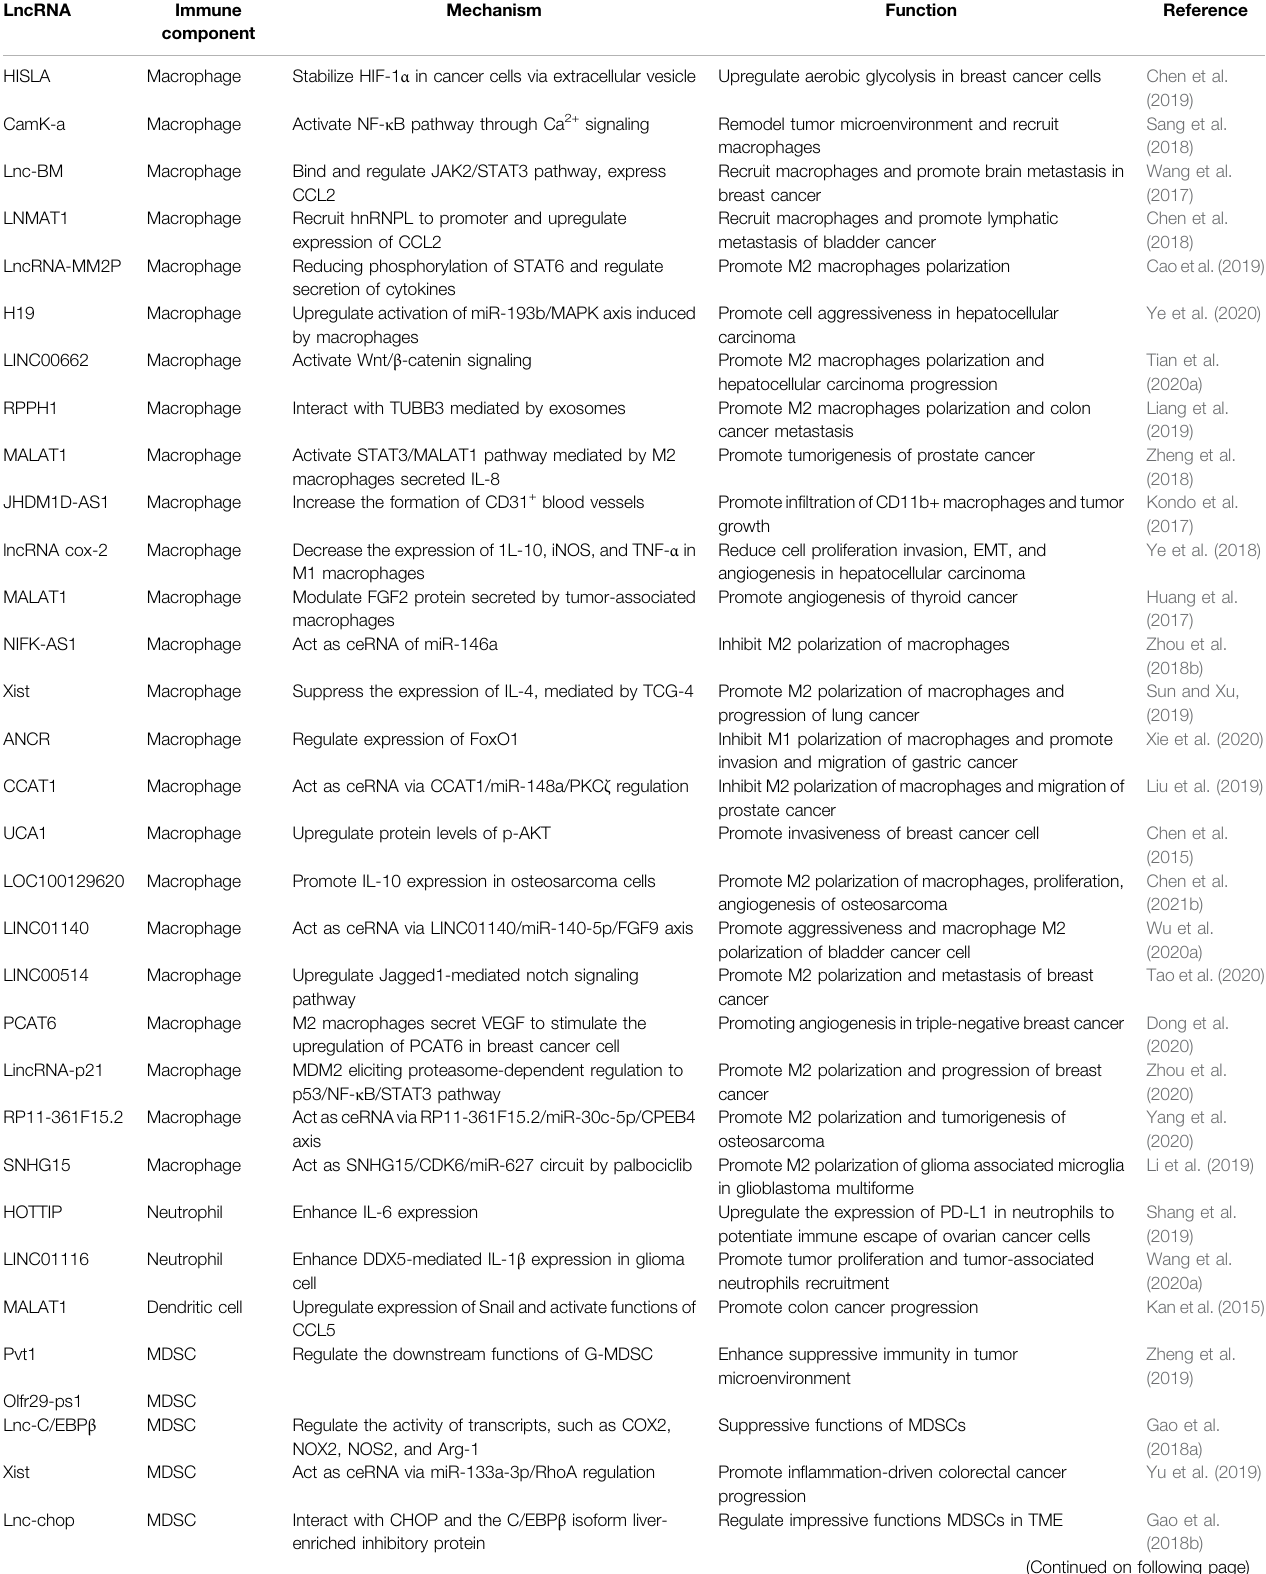
TABLE 1 | Research on lncRNAs as regulators in cancer